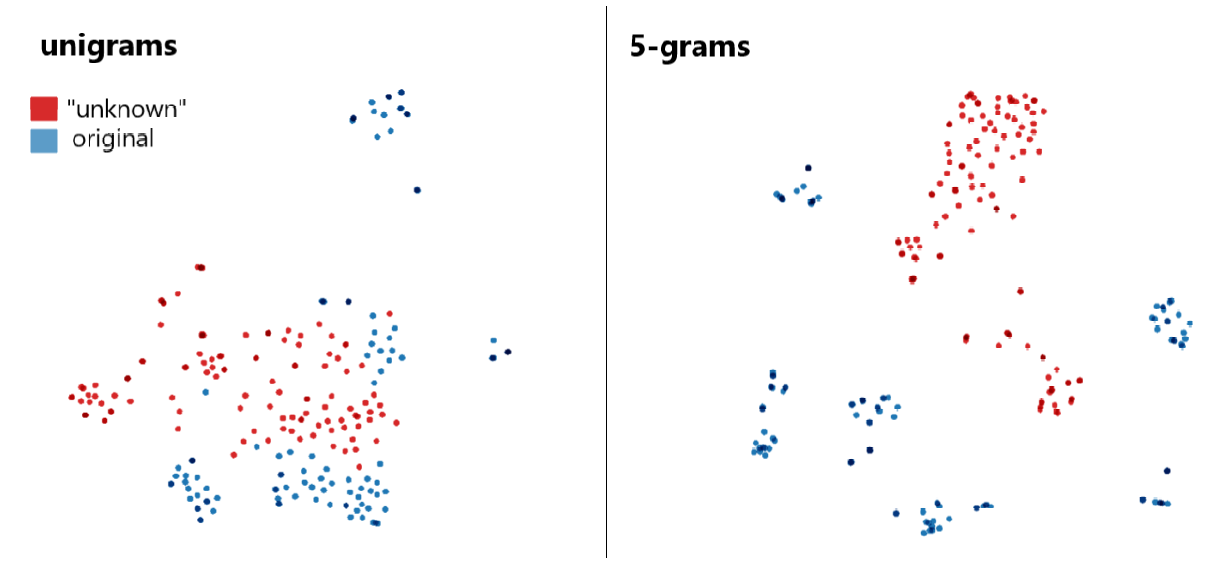
Figure 7. T-SNE visualization for all O riginal ( n = 5) and “unknown” instances in a random state with respect to N -gram